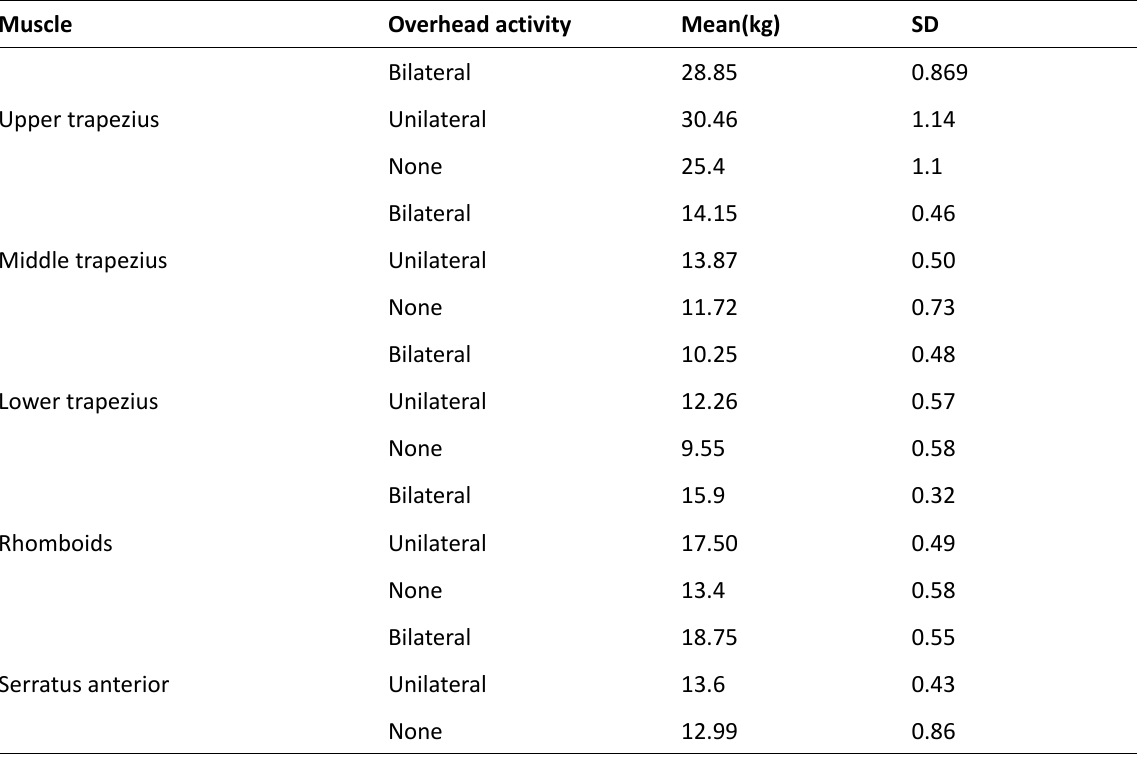
Table 3. Mean Force Production for Each Muscle Across Overhead-Activity-Level Groups